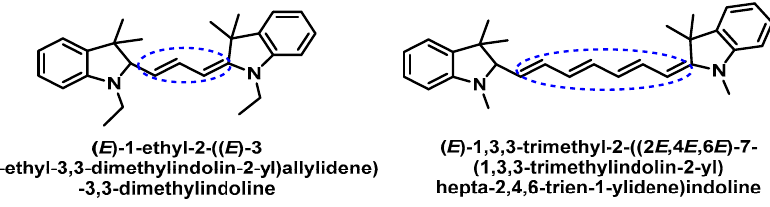
Figure 69. Structure of probes derived from hydrocyanines.